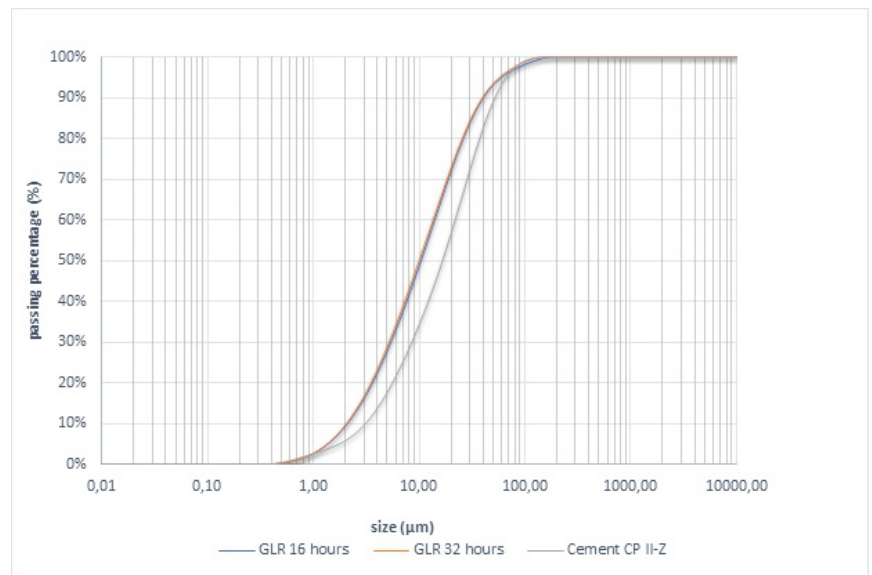
Figure 2. Granulometric distribution of both types of GLR milling and Portland cement CP II-Z